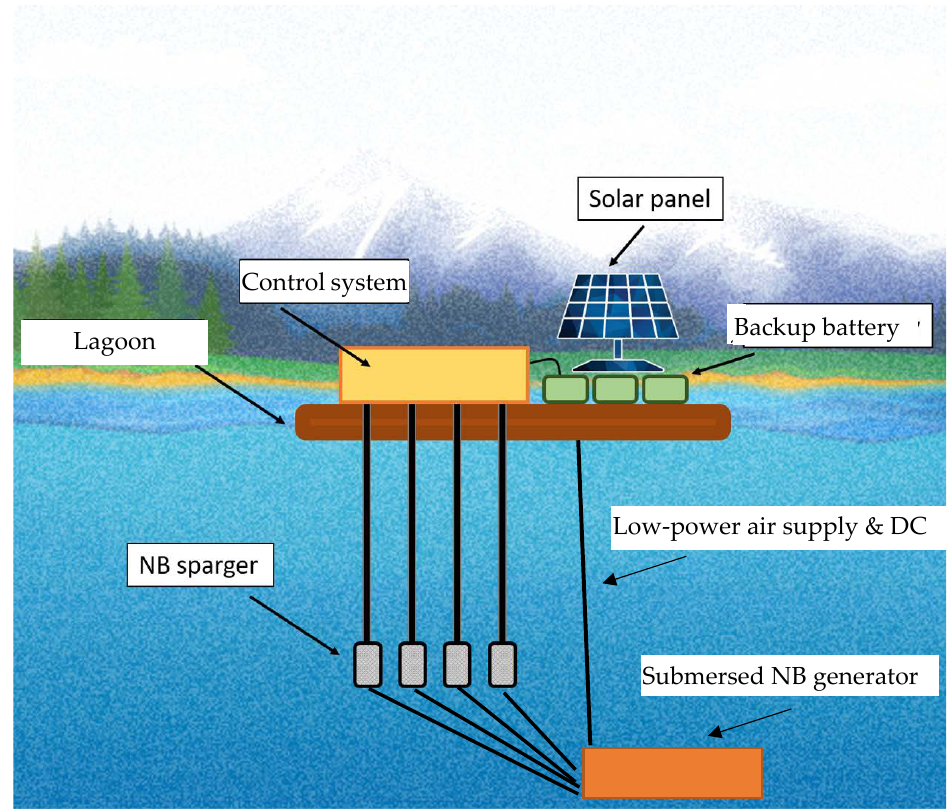
Figure 2. Concept of a submersible, lightweight, solid-state nanobubble generator (with no moving parts and low in maintenance) in the benthic-sludge region, using off-Grid power as per the floating-photovoltaics paradigm. Aside from favourable NB penetration to soften the benthic sludge and the associated biofilm suppression, the “nano-oxygenation” reduces the scope for eutrophication in the water body [85], which is important for mitigating methane emissions globally, in addition, naturally, to the suppression of algal blooms. A feedback-control loop can be employed for electric-field intensity variation in NB-generation and also regulation of bubble-release kinetics in a depth-calibrated way (e.g., by an on/off relay switch, sensitive to straightforwardly-monitored chlorophyll, and/or dissolved-oxygen measurements in the waterway). Naturally, multiple-input/output, Internet control via wireless connection may also be employed at higher cost (considering Internet-signal and bandwidth for data transfer). Image credit: altered from one supplied by M.R.